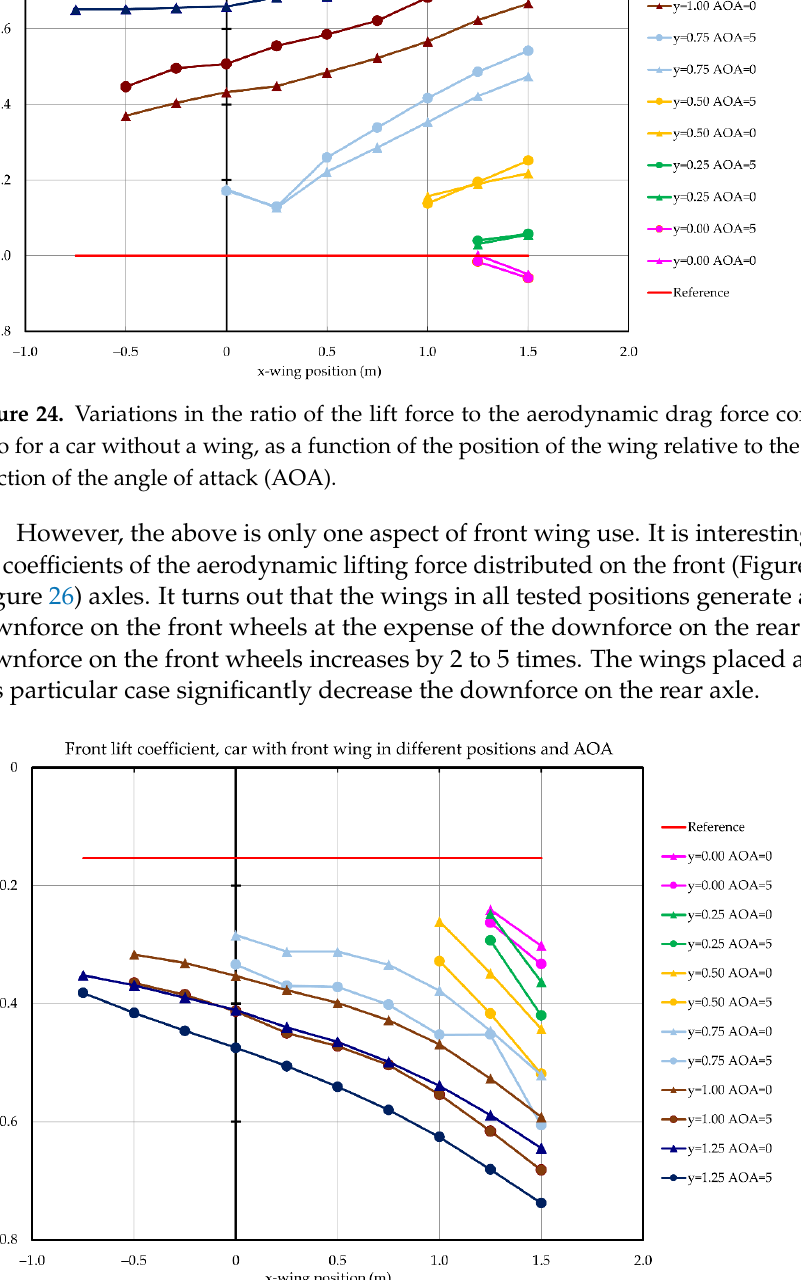
Figure 23. Changes in the lift force acting on the vehicle as a function of the wing position relative to the body and depending on the angle of attack (AOA).